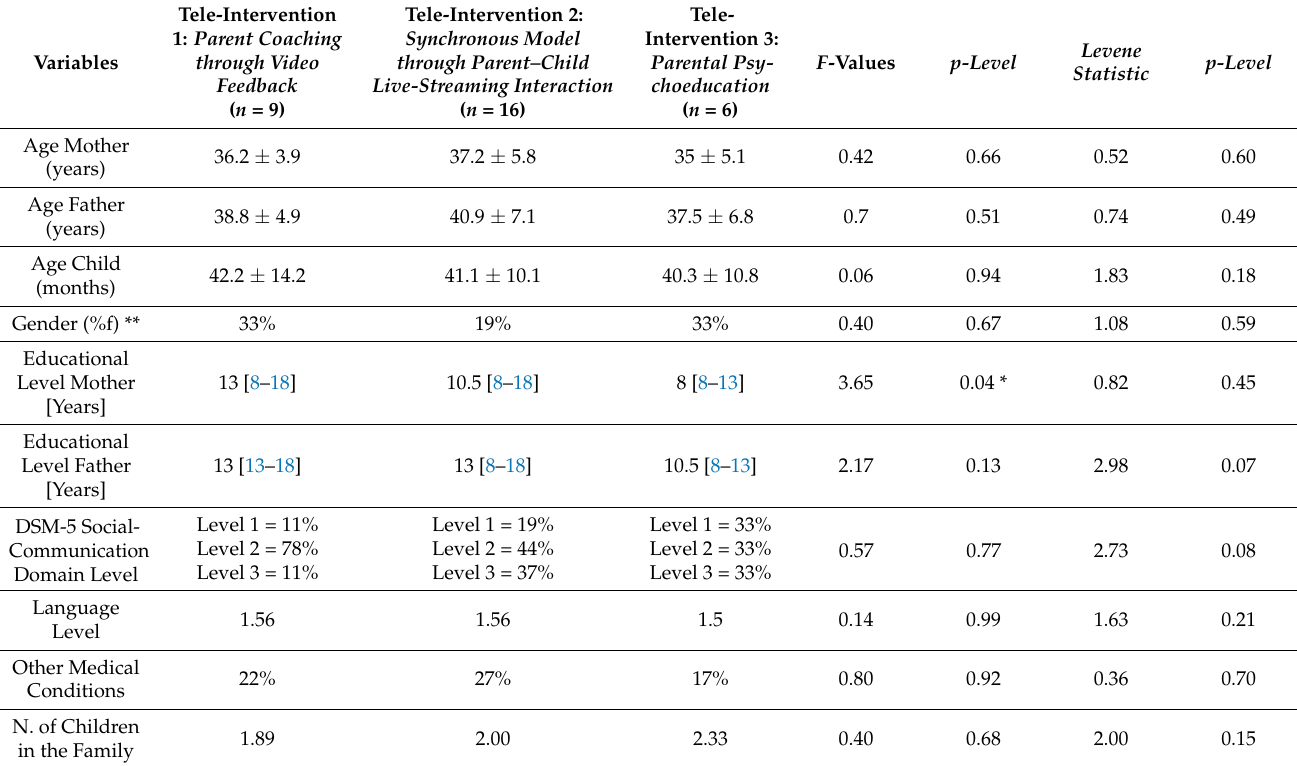
Table 1. Demographic and psychological characteristics of ASD parental groups enrolled in the tele-intervention